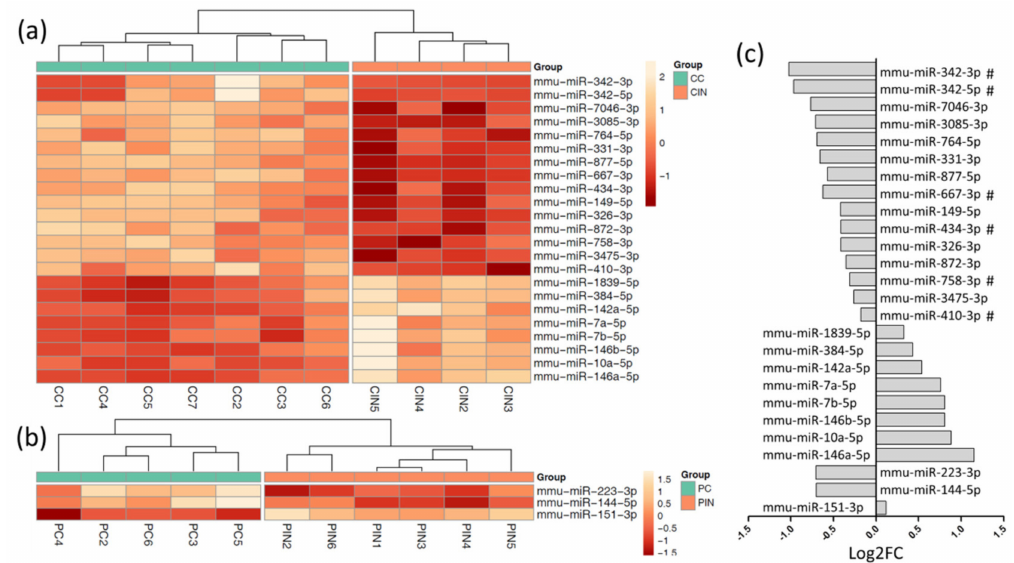
Figure 1. Di ff erentially expressed (DE) miRNAs in Tg501 mice. ( a ) Heatmap of significant DE miRNAs (Benjamini–Hochberg padj < 0.05) in clinical-stage Tg501 mice compared with age-matched controls. ( b ) Significant DE miRNAs (padj < 0.05) in preclinical Tg501 mice compared with age-matched controls. ( c ) Log2 fold change of clinical and preclinical miRNA alterations. Down-regulated miRNAs clustered in chromosome 12 are indicated with hash (#). Abbreviations: CC, clinical control; CIN, clinical inoculated; PC, preclinical control; PIN, preclinical inoculated; Log2 FC, log2 fold change. Table 1. Di ff erentially expressed miRNAs in cervical spinal cord of Tg501 mice. miRNA Regulation /